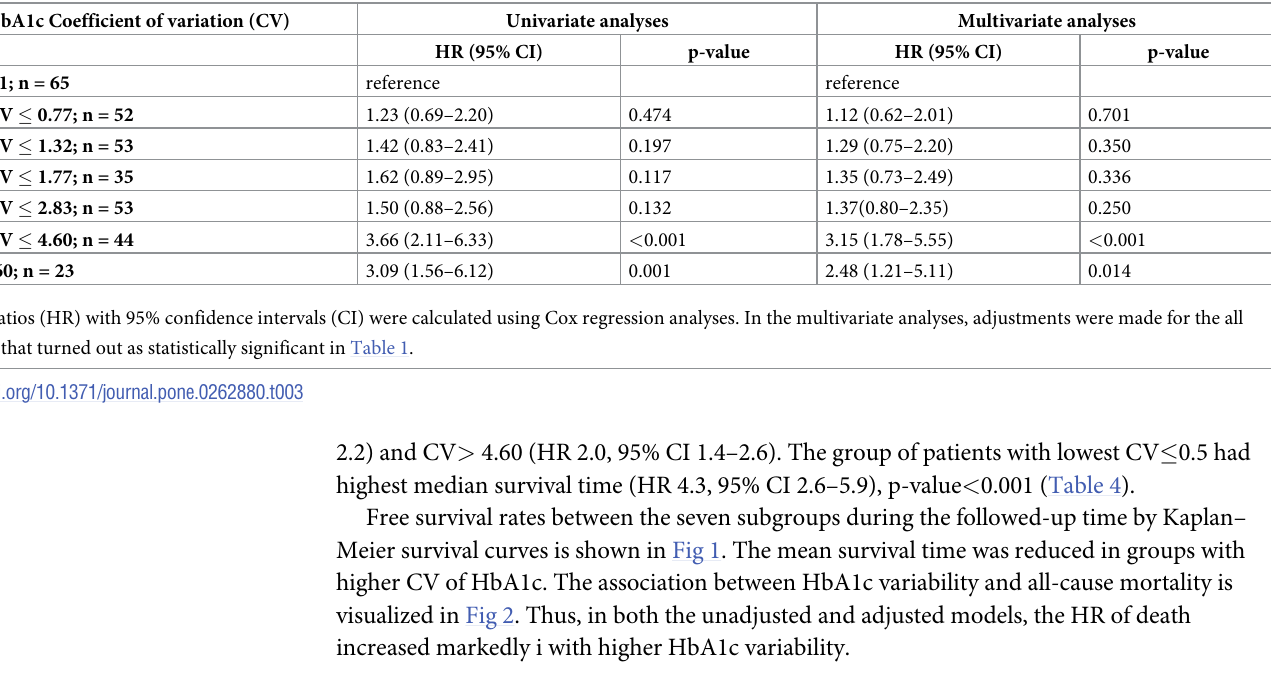
Table 3. Univariate and multivariate analyses of the association between HbA1c variability and the risk of all-cause mortality. HbA1c Coefficient of variation (CV)